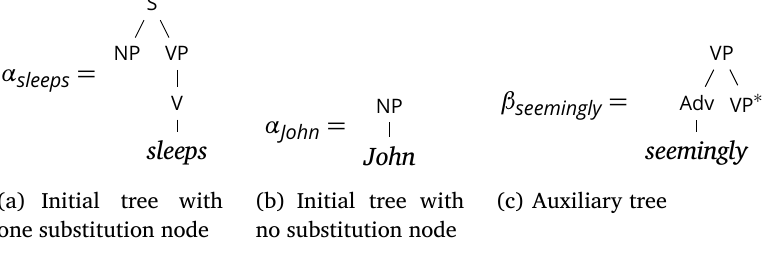
Figure 2: TAG elementary